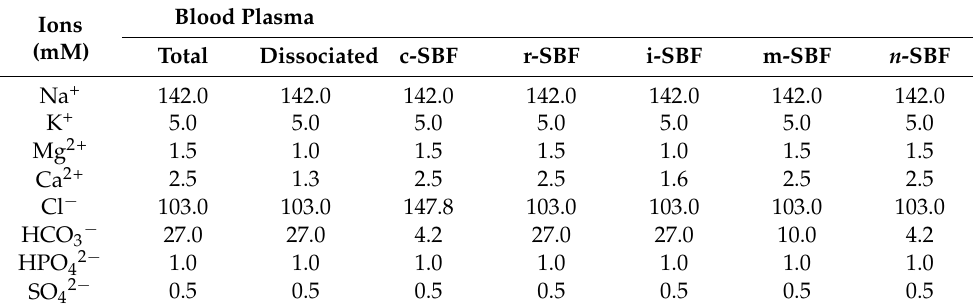
Table 3. Formulations of various simulated body fluids